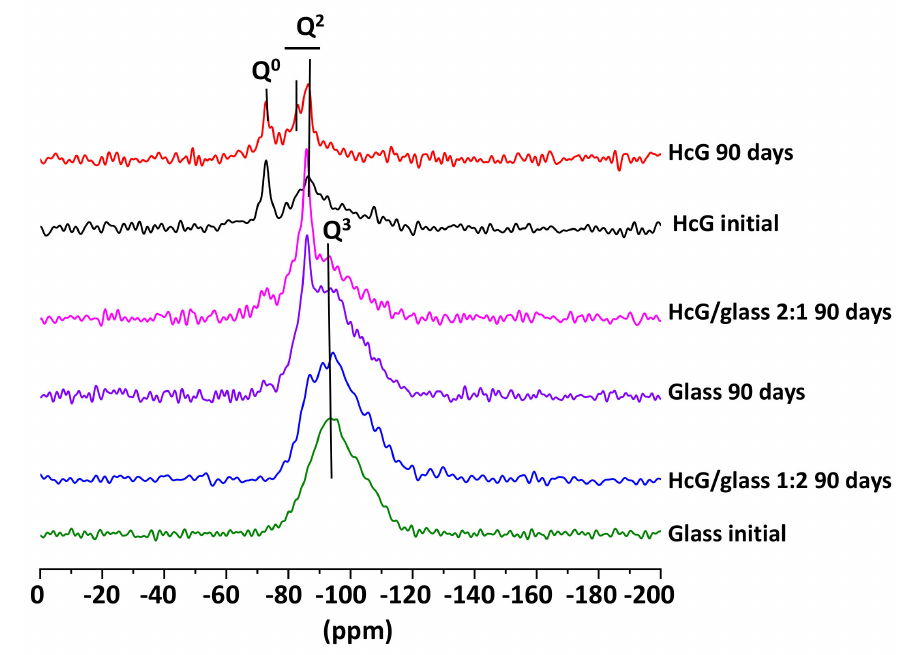
Figure 4. NMR of the 27 Si cores of the initial HcG and glass waste and binary mixtures at 90 days.